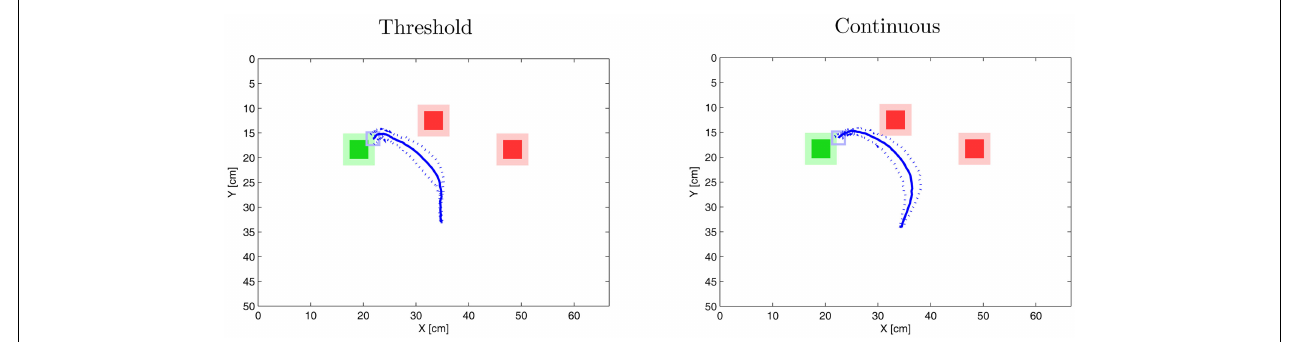
above figure only the trajectories toward the middle distractor were chosen. The trajectory on the right is the effect of the “continuous” hypothesis (see main text for detail). Each mean trajectory shows the results from 5 trials.The broken lines documents the standard